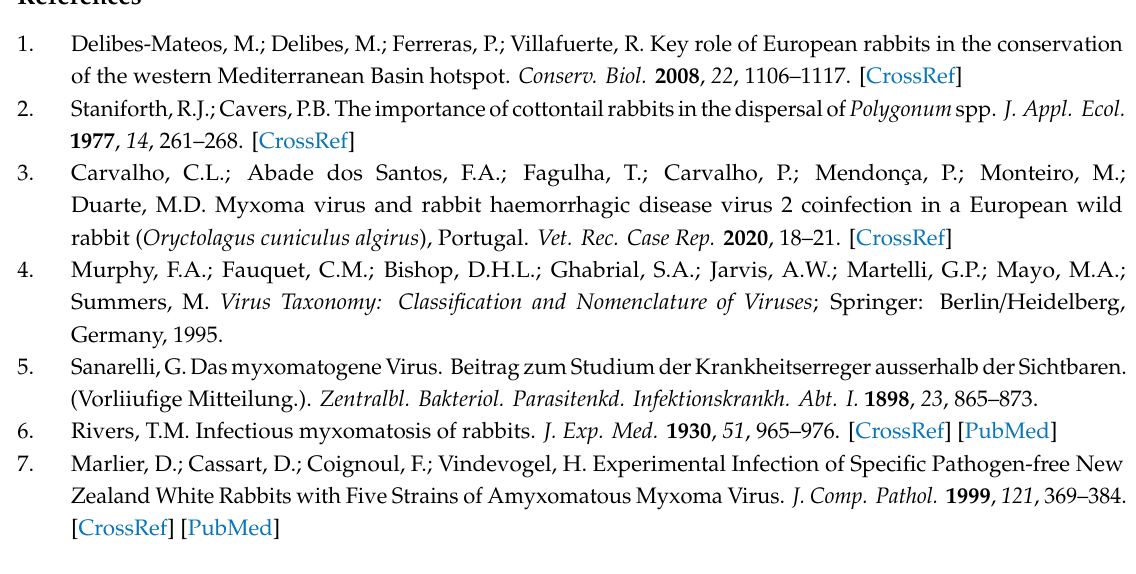
Figure S1: Nucleotide alignment between the M066L from sequence MT940239 with the homologous sequences of M006L from other hare recombinant strains (MK836424 and MK340973) (first to third sequences) and with the M066R from hare and classic MYXV strains from rabbit (fourth to ninth sequences). Figure S2. Alignment of the truncated M066L protein sequence from a natural recombinant MYXV (deduced from sequence MT940239) with the homologous regions of M066R proteins deduced from hare recombinant MYXV strains (MK836424 and MK340973) and classic MYXV strain